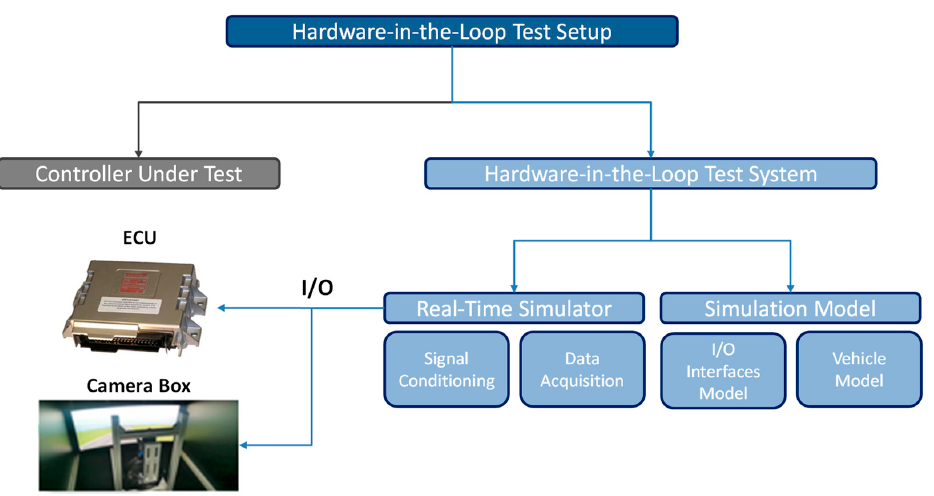
Figure 3. Typical HIL set up for ACC